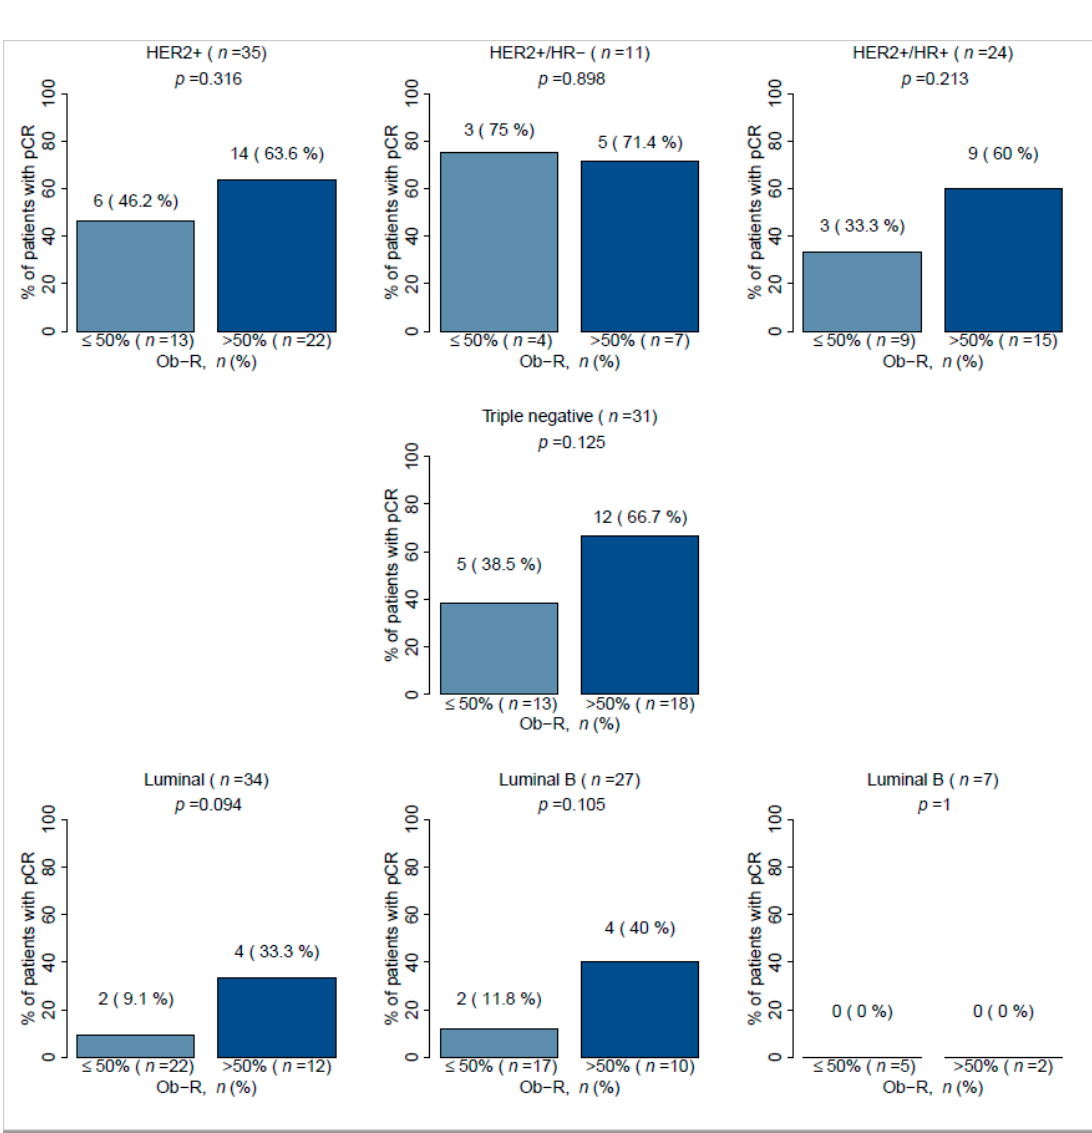
Figure 5. Association between Ob-R cell positivity and pCR in accordance to breast cancer molecular subtypes. HER2: Human epidermal growth factor receptor 2, HR: Hormonal receptor, Ob-R: leptin receptor, pCR: Pathological complete response.